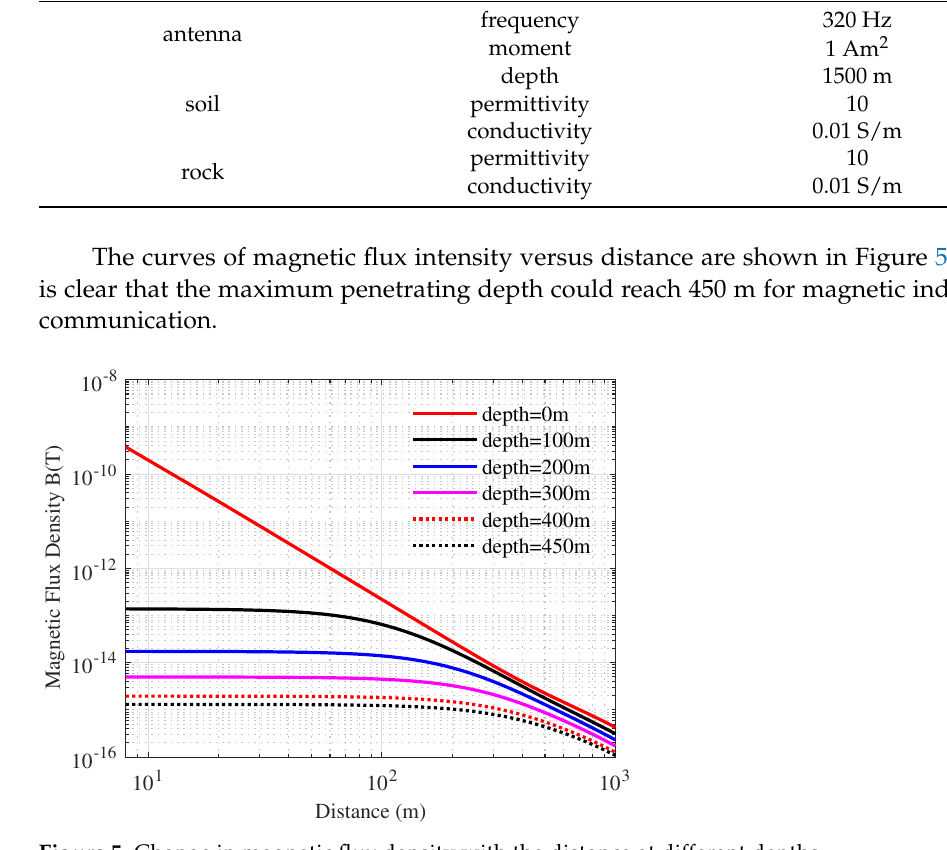
Figure 5. Change in magnetic flux density with the distance at different